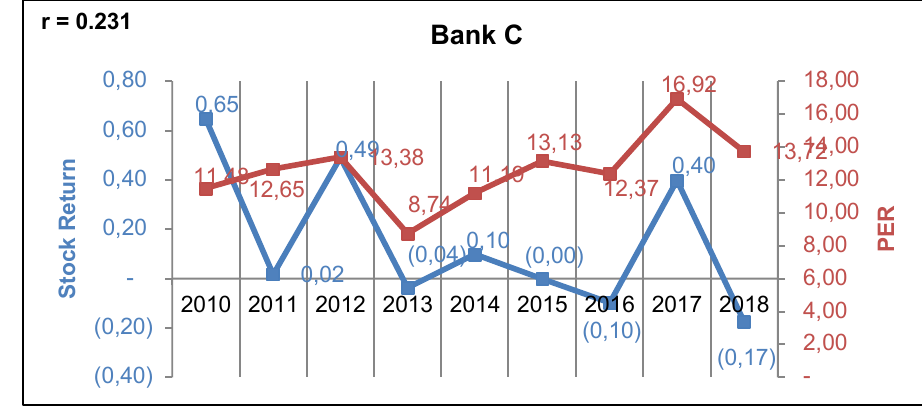
Figure 3: For Bank C Banks A and B appear to have returns and PER that trends in a similar manner with slight deviations in 2015 and 2016. Bank C had trend deviation in 2015, then from 2016 to 2018, the two variables followed similar trends